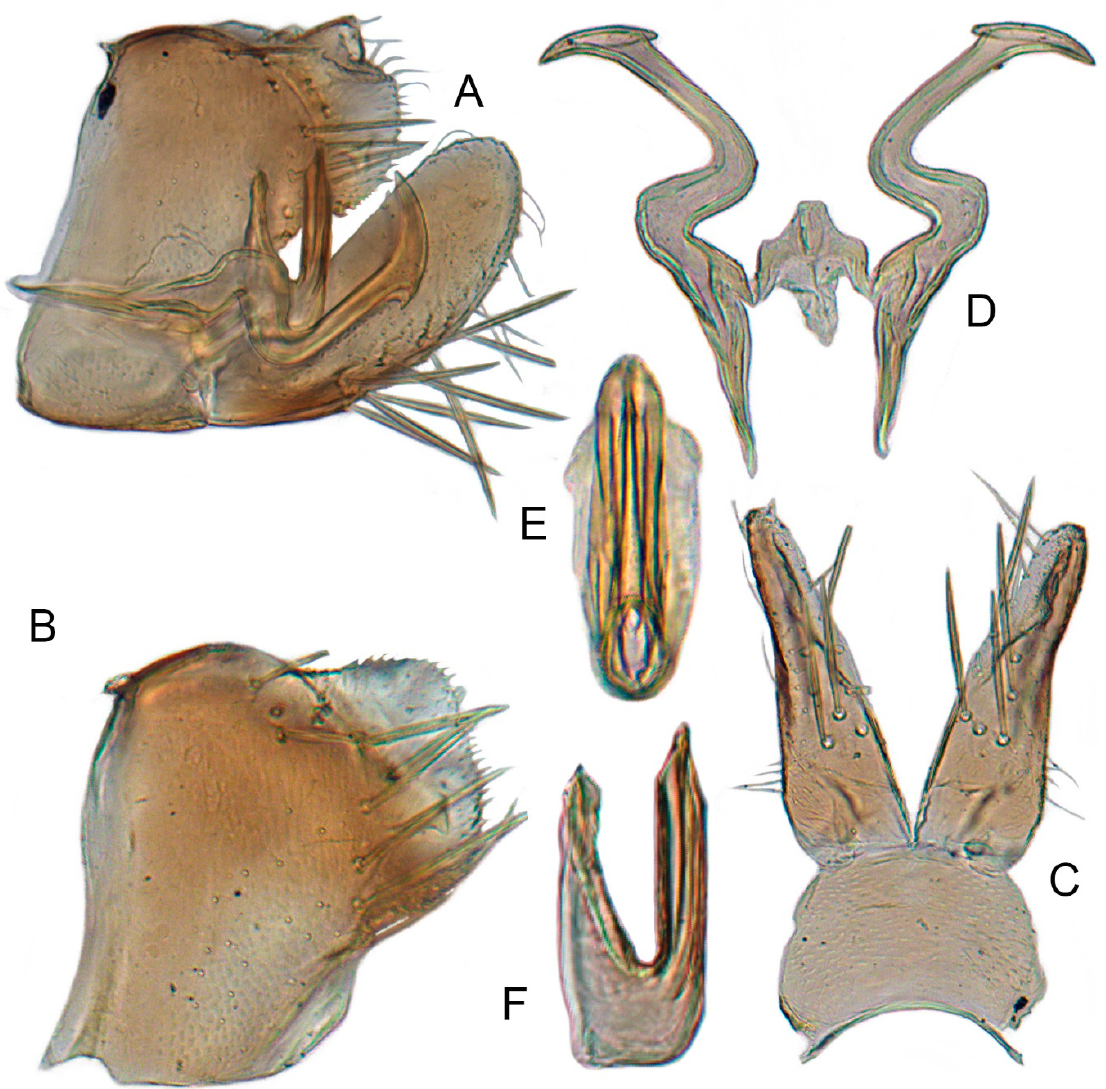
Figure 4. Xestocephalus ishidae Matsumura, 1914, n. rec. ( A ) Male genital capsule, lateral view; ( B ) pygofer lobe, lateral view; ( C ) subgenital plates and valve, ventral view; ( D ) style and connective, ventral view; ( E ) aedeagus, posterior view; ( F ) aedeagus, lateral view.